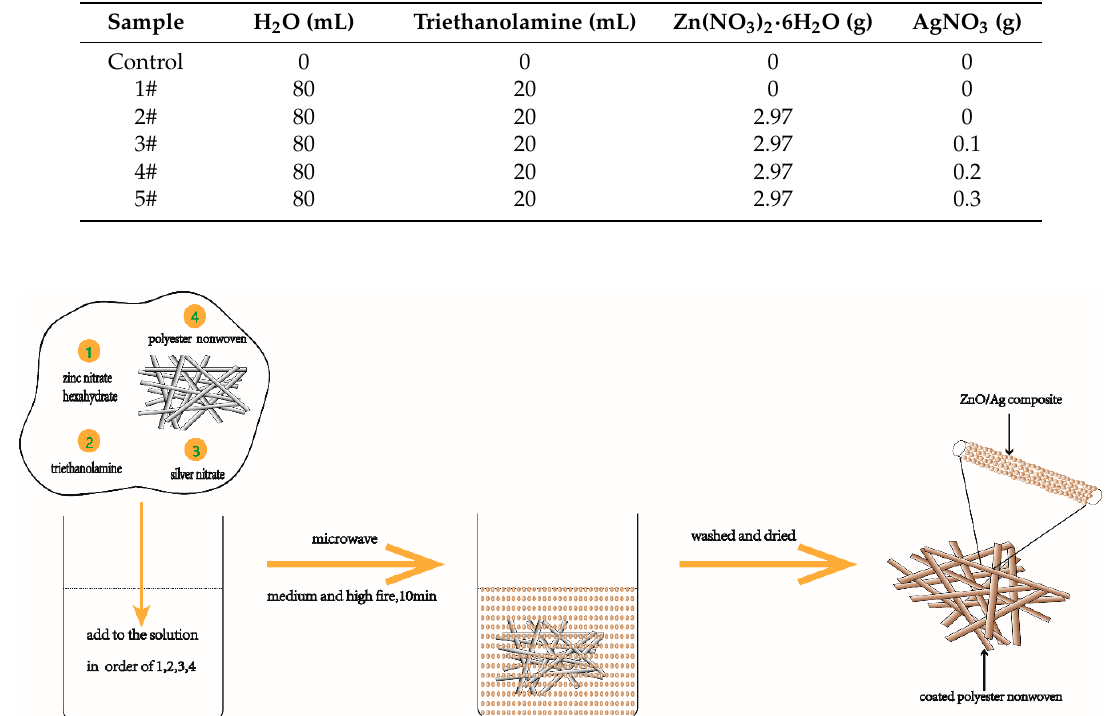
Table 1. Samples prepared under different processing conditions.